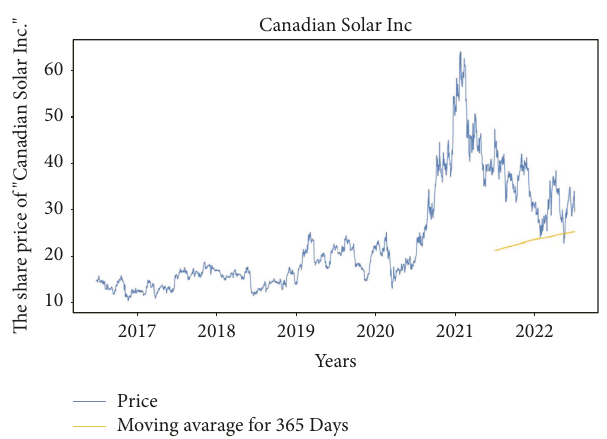
Figure 4: Predicting the stock price of Canadian Solar Inc (The blue color shows the real stock price, yellow color shows projected stock price). Source: